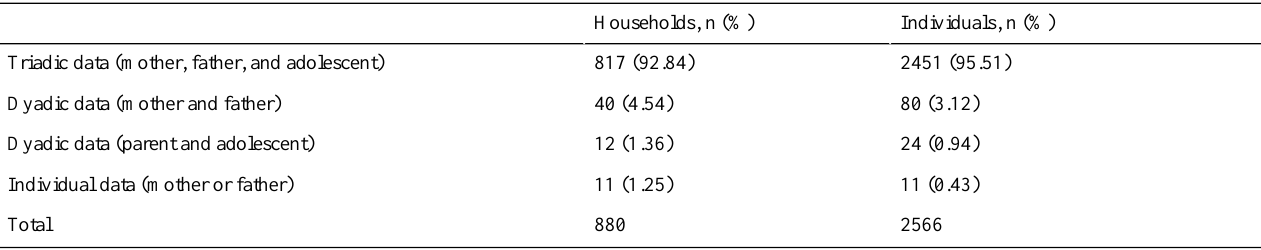
Table 1. Overview of the RMFC dataset